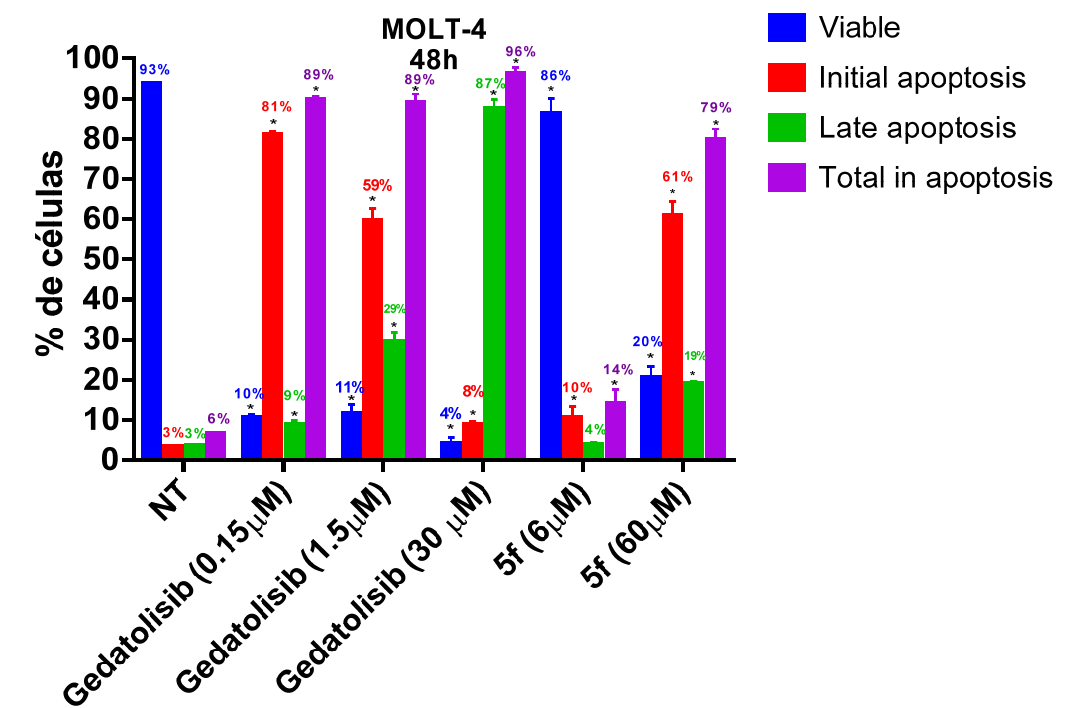
Figure 5. Evaluation of phosphatidylserine externalization and cell membrane integrity caused by gedatolisib ( 4 ) and LASSBio-2252 ( 5f ) against MOLT-4 cell line in 48 h. Data presented as mean ± standard error of the mean of three independent experiments. * p < 0.05 compared to the untreated group (DMSO 1%).